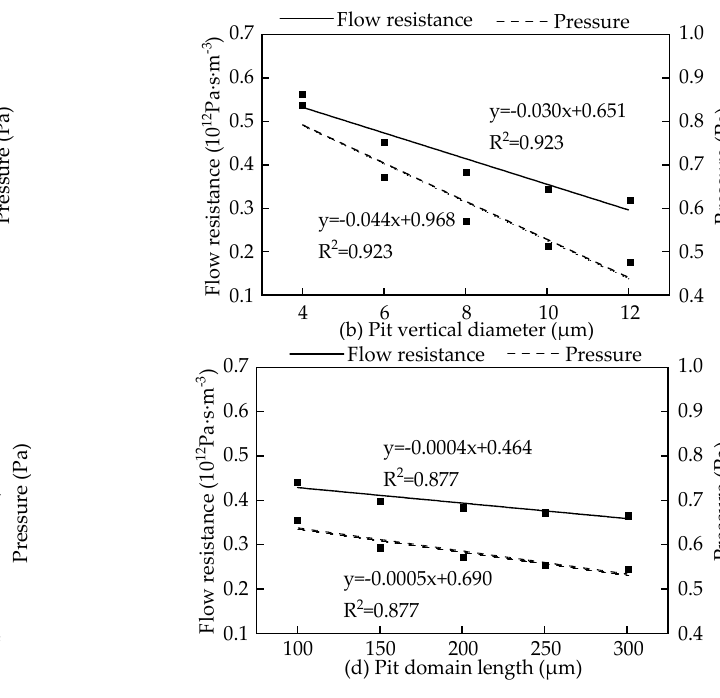
Figure 9. Flow resistance trends of the pit structure.